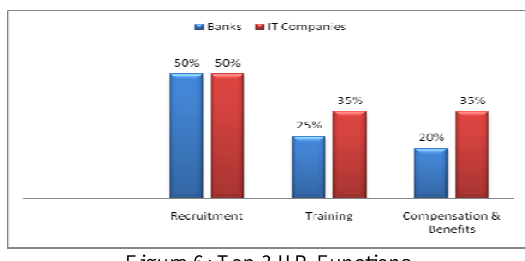
Figure 6: Top 3 HR